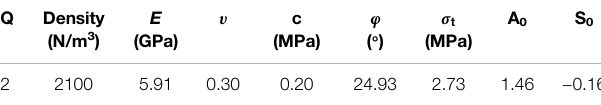
TABLE 3 | Initial mechanical parameters of rock mass (before deterioration).